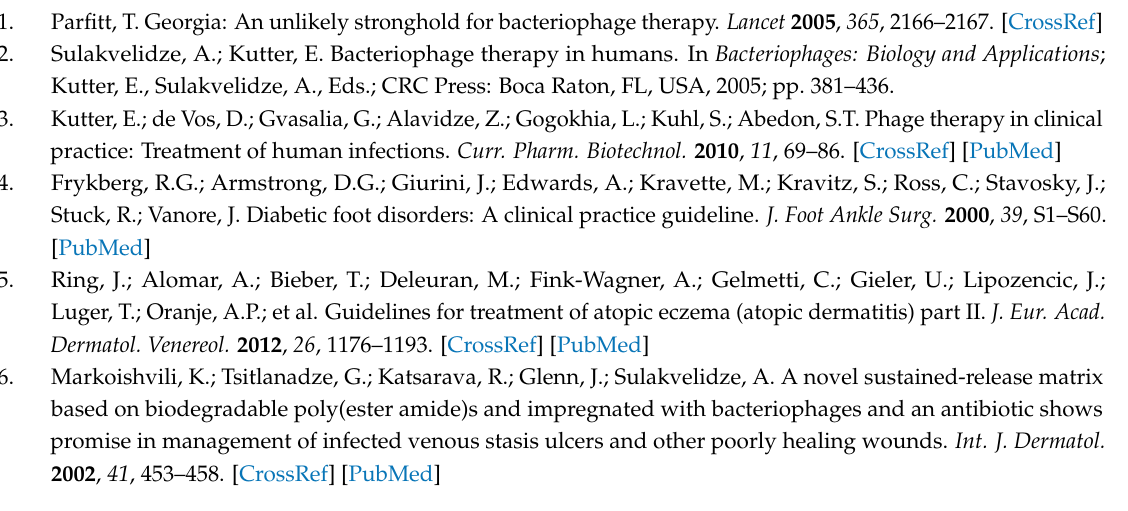
Figure S1: Synthesis scheme of poly(ester urea) 1L6, Figure S2: FTIR spectrum (a) and X-ray diffraction profile (b) of poly(ester urea) 1L6, Figure S3: Plots of weight loss versus exposure time for 1L6 films exposed to proteinase K (black symbol), α -chymotrypsin (garnet symbol) and lipase (blue symbol) media. Figure S4: Scanning electron micrographs of 1L6 films after 19 days of exposure to PBS (a) and α -chymotrypsin (b) media at 37 ◦ C. Figure S5: Plots of weight loss versus exposure time for 1L6 scaffolds exposed to proteinase K (green symbols) α -chymotrypsin (blue symbols) and lipase (red symbols) media. Figure S6: SEM micrographs of 1L6 scaffolds after exposure to an α -chymotrypsin medium at 37 ◦ C for 3 (a,d), 6 (b) and 8 (c) days. Figure S7: Calculated modulus of the electric field for a potential of 30 kV, Figure S8: TEM micrographs showing the morphology of Myoviridae (a), Siphoviridae (b) and Leviviridae (c) phages that form part of the Phagestaph commercial preparation after exposition to a 40 kV/cm electric field. Scale bars 100 nm, Figure S9: TEM micrographs showing the morphology of representative Siphoviridae (a) and Leviviridae (b) phages that were recovered from electrospun 1L6 scaffolds directly loaded with phages (a) and with carbonate particles having adsorbed phages